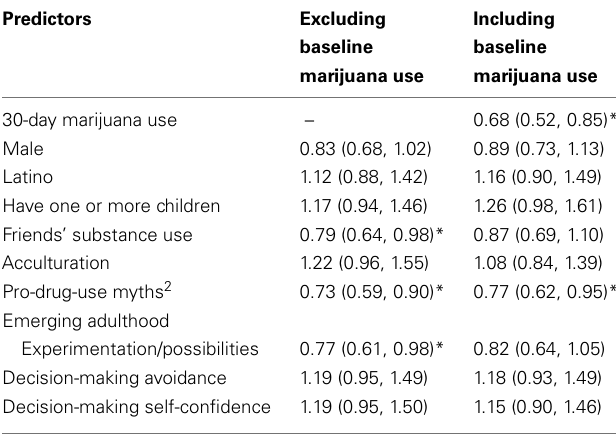
Table 3 | Final multivariate models: interpersonal, cultural/attitudinal, and intrapersonal variables predicting marijuana cessation (significant at <